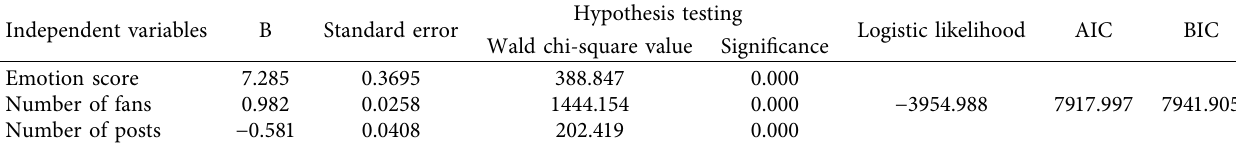
Table 5: Negative binomial regression parameter estimates (prosocial posts and number of comments).